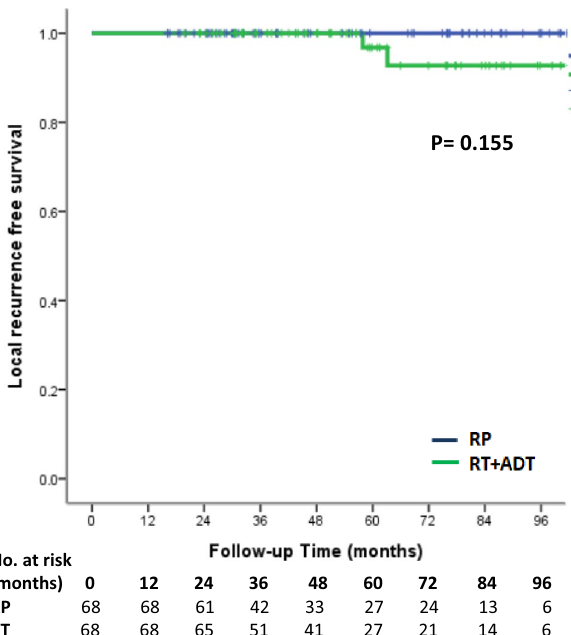
Figure 2. Kaplan–Meier analysis of local recurrence free survival in propensity-score matched patients. For each treatment group, we generated Kaplan–Meier survival curves for local recurrence according to management method, and we also calculated a log-rank test to evaluate the association of local recurrence with different management method among propensity-score matched patients.